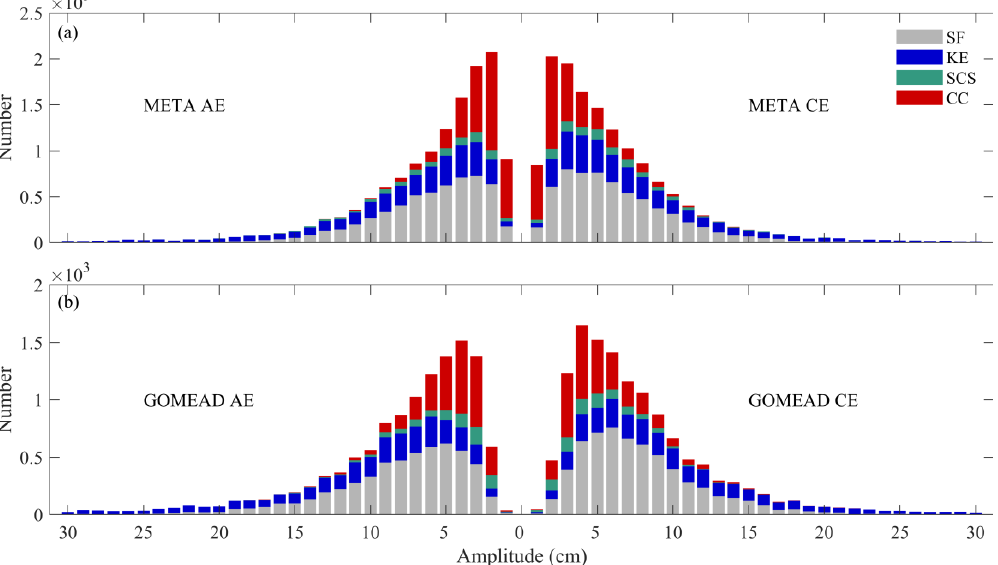
Figure 5. Histograms of eddy amplitudes, ( a ) META; ( b ) GOMEAD. AEs (CEs) with amplitudes greater than 20 cm accounted for 6% (5%) in the GOMEAD dataset and 3% (3%) in the META dataset. The amplitudes of eddies in the CC region and SCS region are both small. In the CC region, the META dataset has more small-amplitude eddies, while the SCS region contains more small-amplitude eddies as reported by the GOMEAD